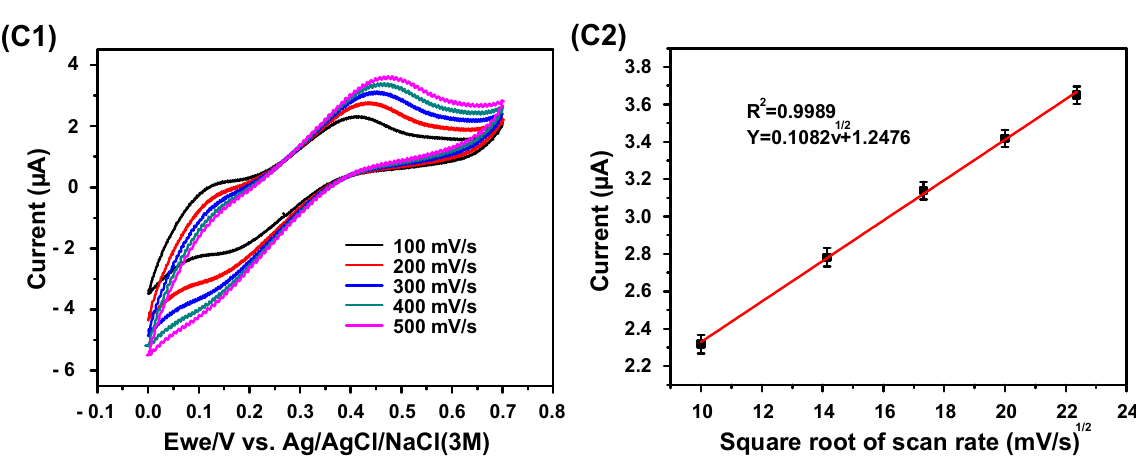
Figure 4. Electrochemical characteristics of the proposed electrode for electrolyte detection: ( A1 , B1 , C1 ) cyclic voltammo- grams of the proposed different electrodes at scan rates ranging from 100 to 500 mV/s in 50 mM KCl, 140 mM NaCl, and 1 mM KCl solutions, respectively; ( A2 , B2 , C2 ) the corresponding Randles–Sevcik curves of the cyclic voltammograms in ( A1 , B1 , C1 ), respectively.